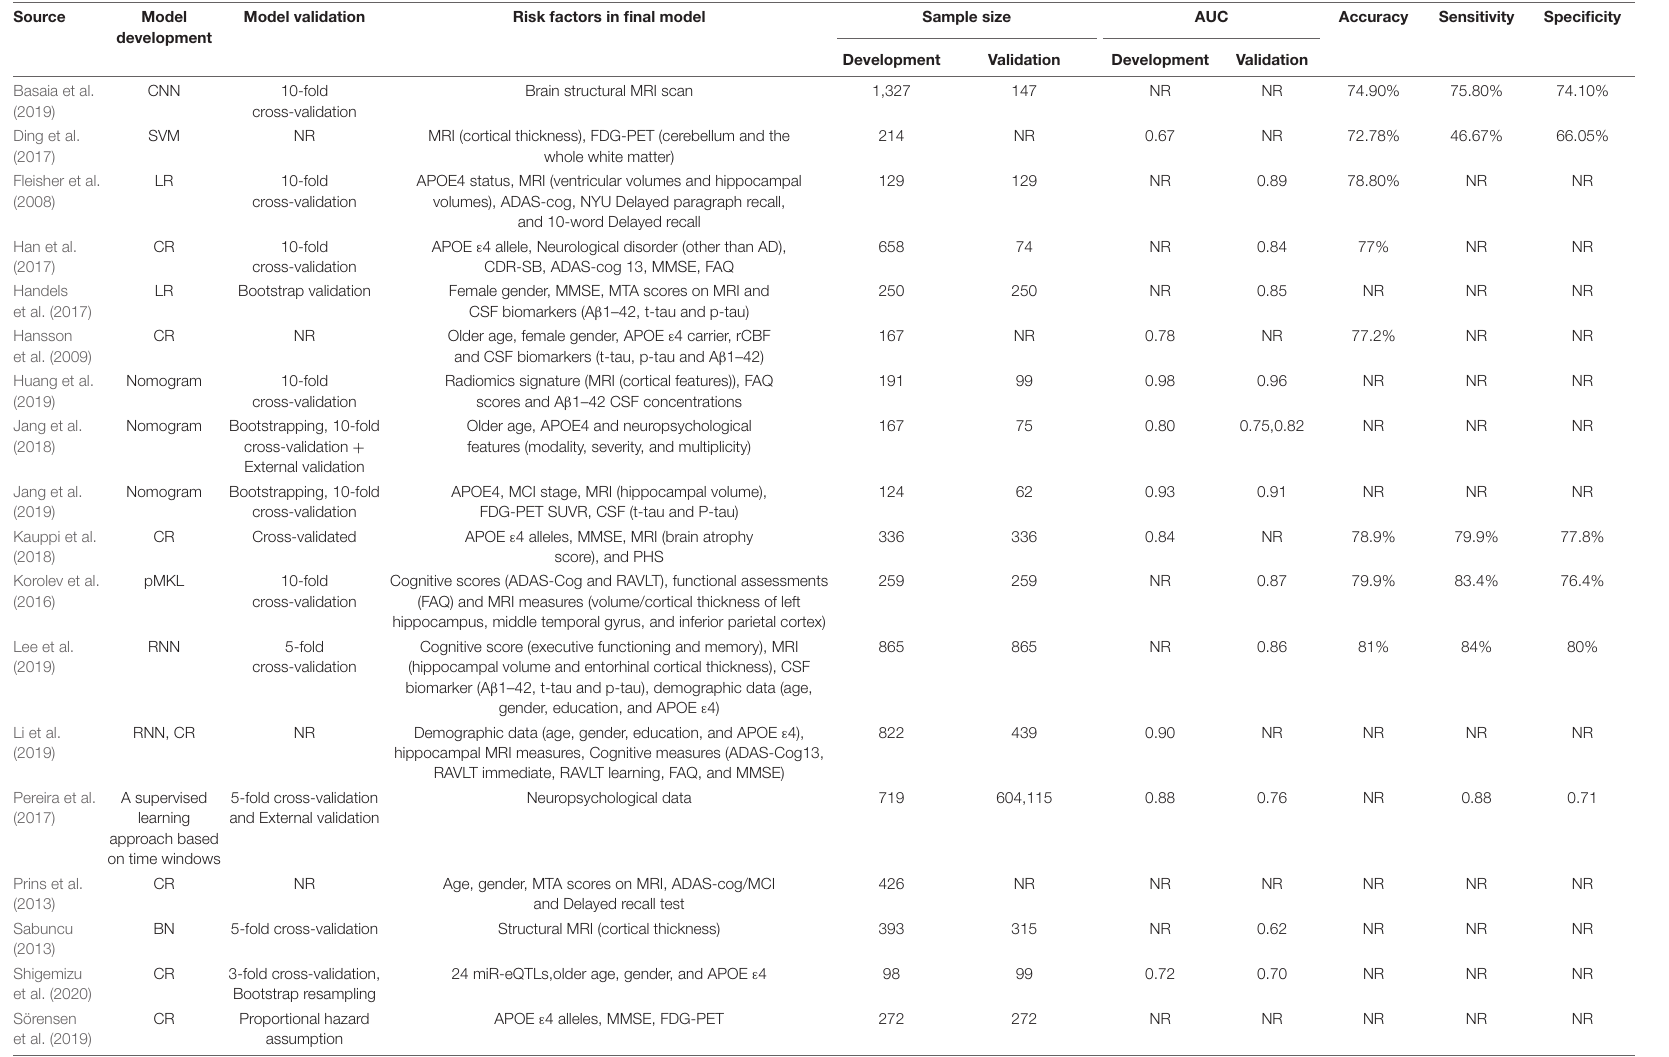
TABLE 2 | Modeling, verification methods, and predictive factors for included studies ( n = 18).